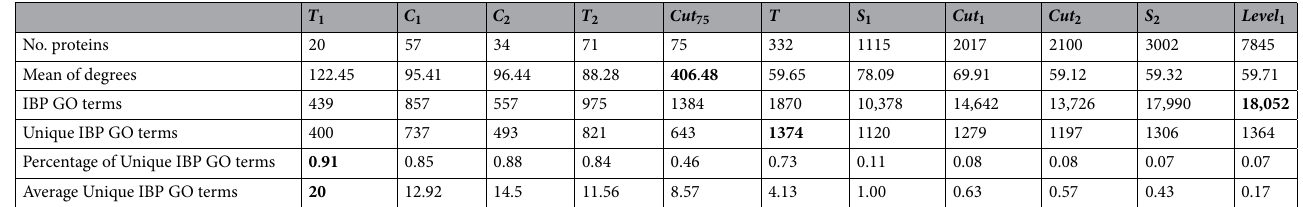
Table 2. The summary of statistics of the proposed sets. The first row shows the size of T 1 , C 1 , C 2 , T 2 , Cut 75 , T , S 1 , Cut 1 , Cut 2 , S 2 , Level 1 sets. The second row shows the mean of degrees of mentioned sets. The number of 1374 IBP GO terms overlapped with the subsets and their number of unique IBP GO terms are collected in the third and fourth rows, respectively. The ratio of the unique IBP GO terms to total IBP GO terms and the